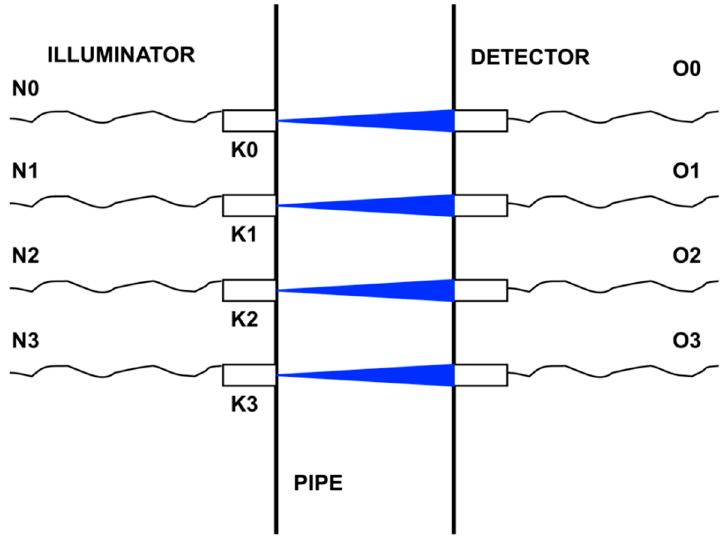
Figure 4. The rule of measuring light absorption.